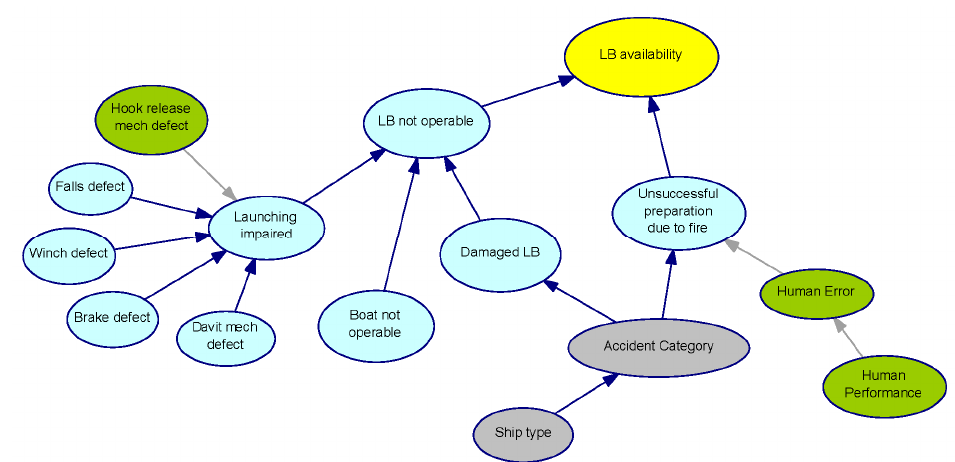
Figure A2. A Bayesian network for lifeboat availability in flooding accidents (03 FL ).